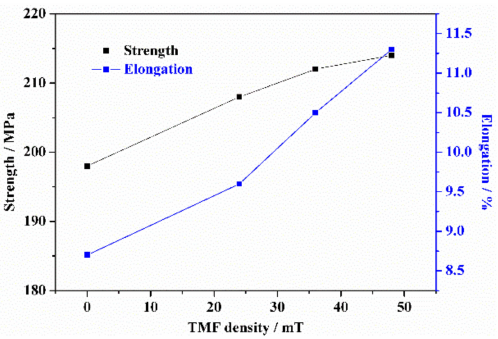
Figure 6. The tensile strength and elongation of Al-alloys solidified under